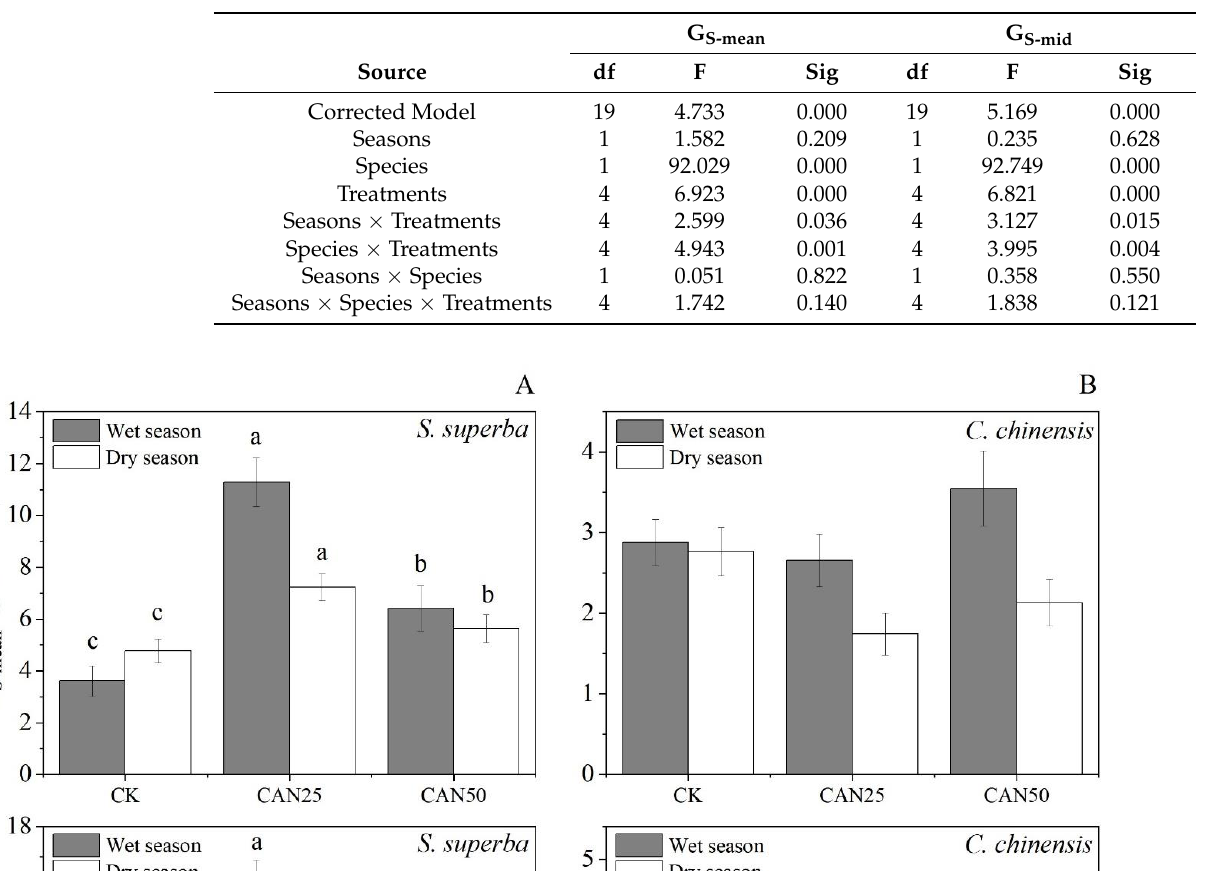
Table 2. ANOVA on the G S-mean and G S-mid .